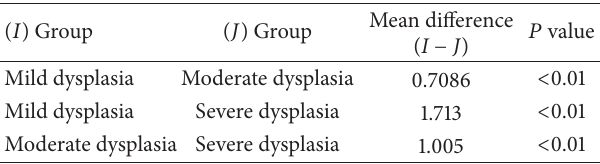
Table 2: Difference between podoplanin expression between vari- ous groups of oral leukoplakia (Tukey HSD test).